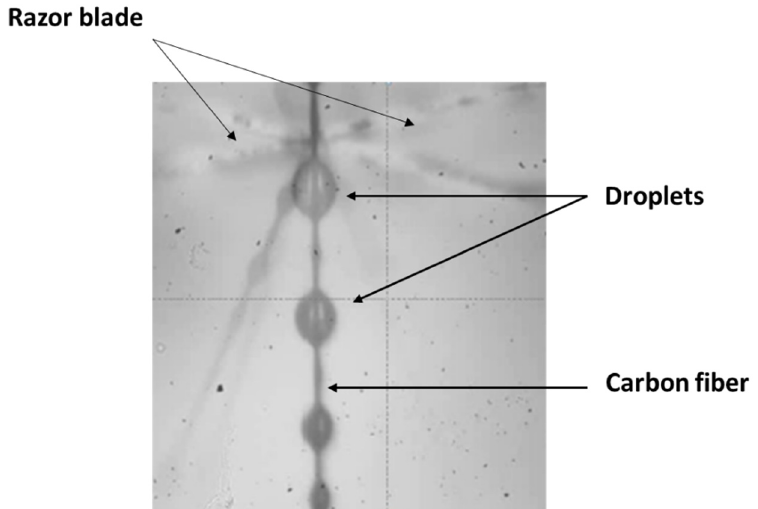
Figure 7. Microbond test set up view from the visual acquisition.